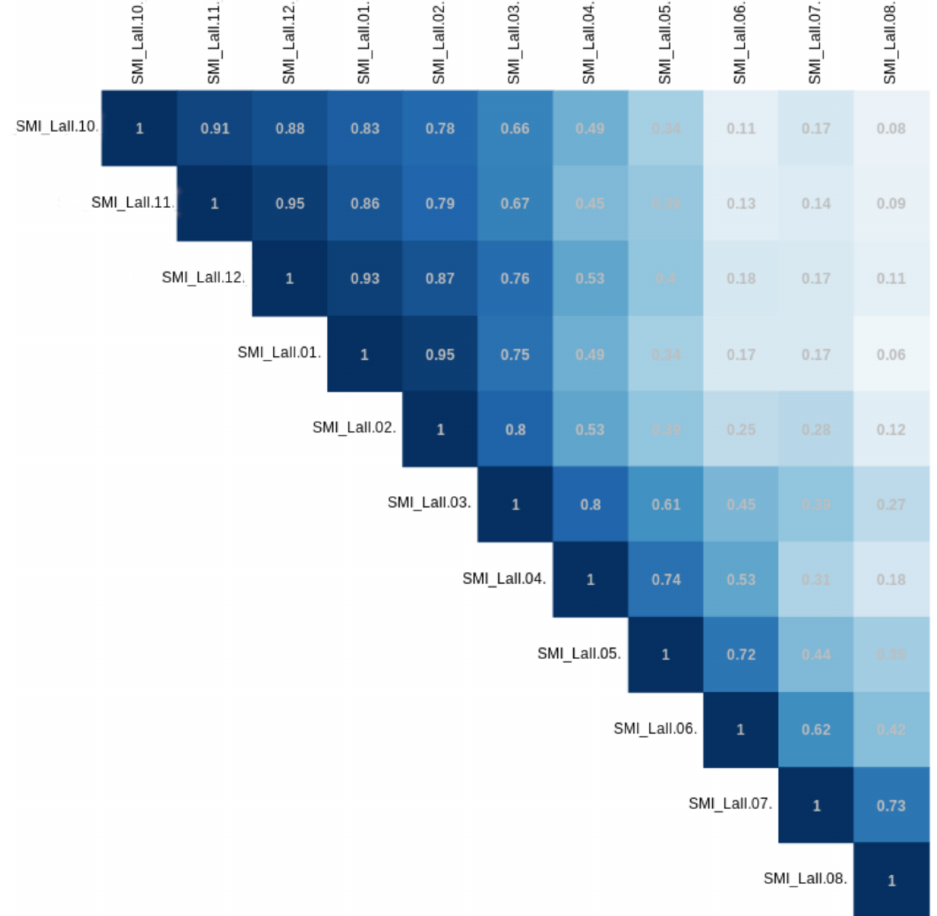
Figure A2. Correlation plot (Pearson correlation coefficient) of the soil moisture index for the entire root zone (Lall) for all months of the season of winter wheat. The SMI variables of October to December (10–12) refer to the previous year, since winter wheat is usually planted in late autumn and harvested in the summer of the following year.